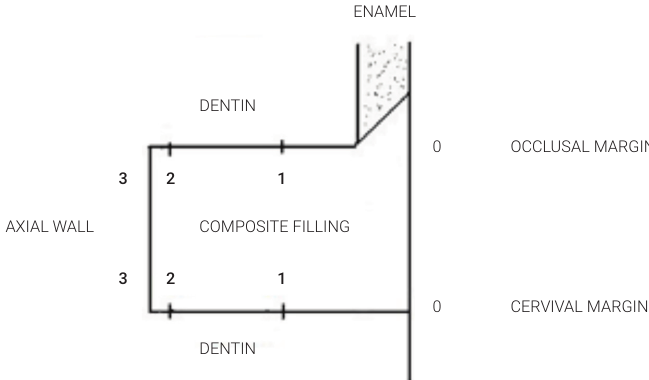
Figure 1. Schematic view of microleakage scores in the occlusal and gingival